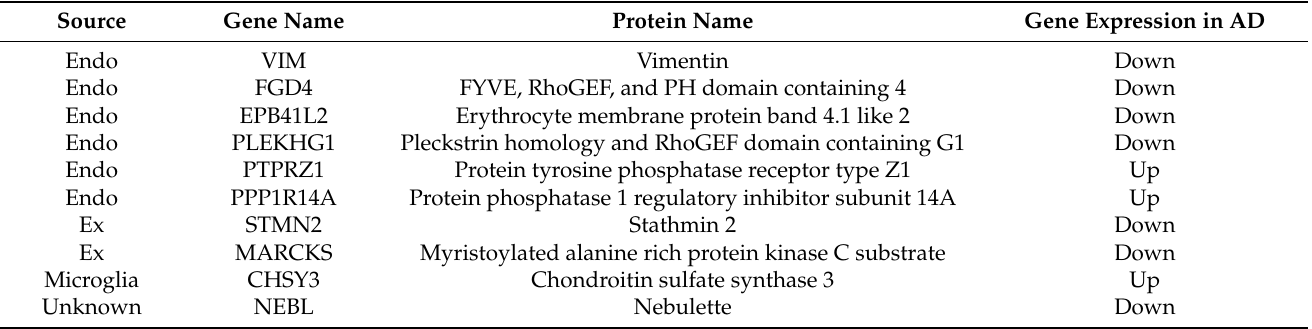
Figure 2. The Venny map overlapped the DEGs of prefrontal cortex and entorhinal cortex and DEPs of serum of AD patients. ( A – H ) The DEGs/DEPs for 8 cell types, including astrocytes ( A ), endothelial cells ( B ), excitatory neurons ( C ), inhibitory neurons ( D ), microglia ( E ), oligodendrocytes ( F ), OPC ( G ), unknown cells ( H ). Table 2. DEGs/DEPs in AD. Endo: endothelial cells; Ex: excitatory neurons. The “down” represents a down-regulation of this gene expression in AD individuals compared to controls. The “up” represents a up-regulation of this gene expression in AD individuals compared to